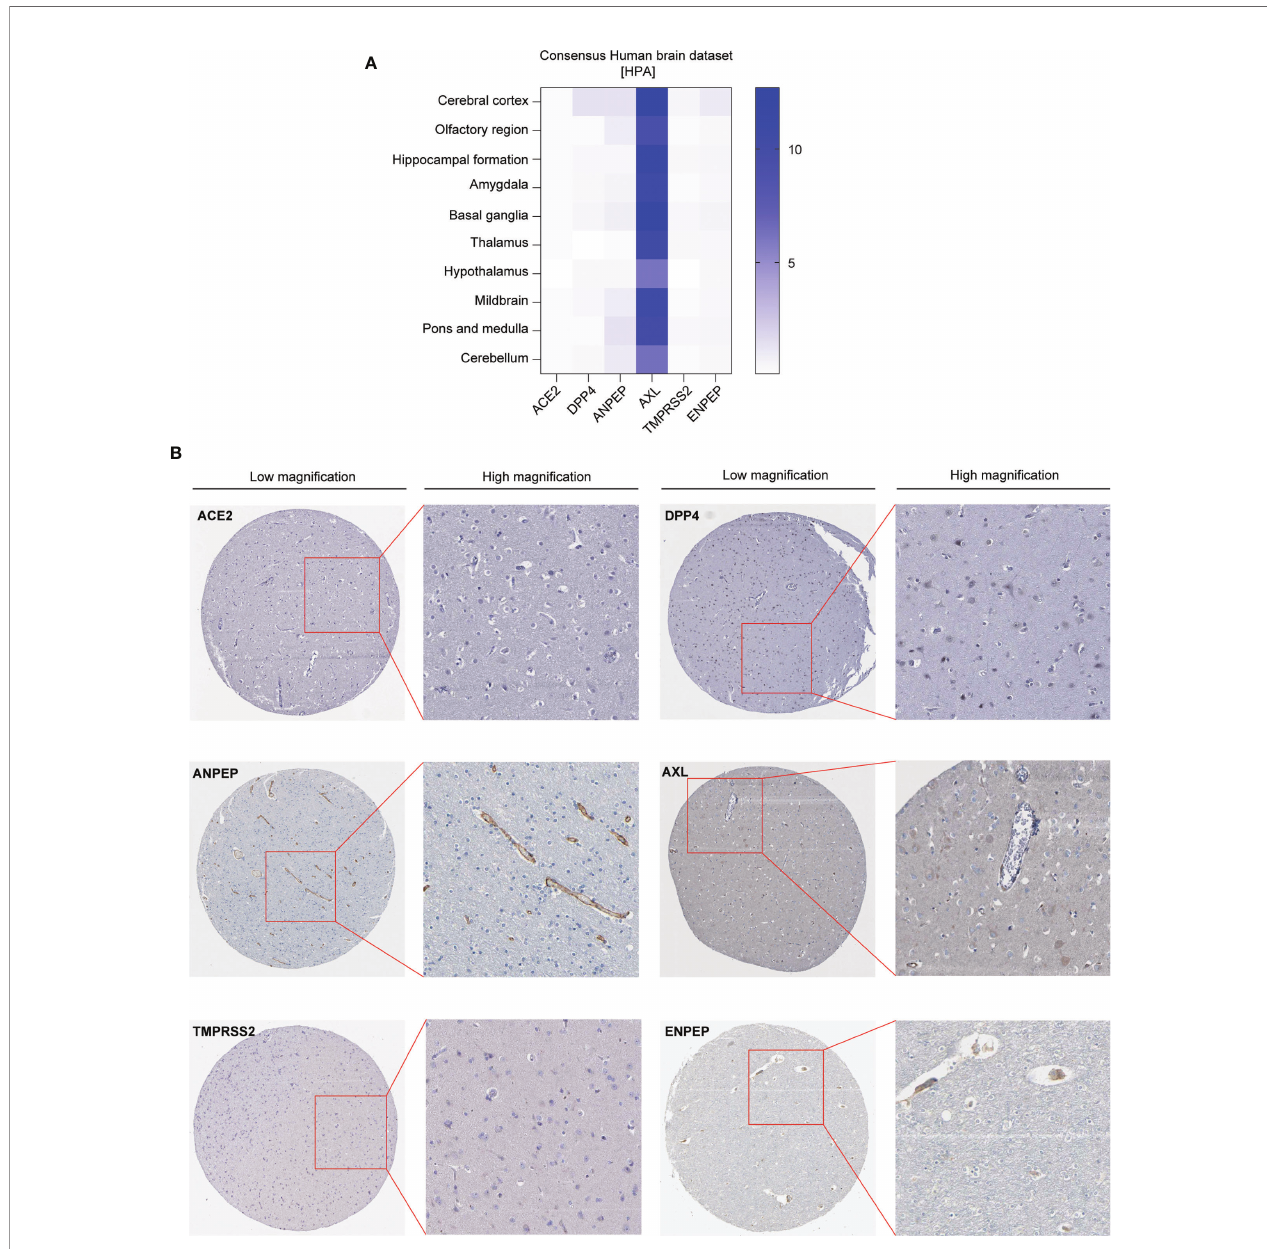
FIGURE 1 | Expression pro fi le of coronavirus receptors in different regions of the brain. (A) Human brain datasets. Heatmap of the expression pro fi les of ACE2, DPP4, ANPEP, AXL, TMPRSS2, and ENPEP extracted from the consensus human brain datasets of the Human Protein Atlas (n = 441) (B) Representative image of immunohistochemistry images of coronavirus receptors in the cerebral cortex of human brain (source: The Human Protein Atlas; https://www.proteinatlas.org/ humanproteome/brain) (n =